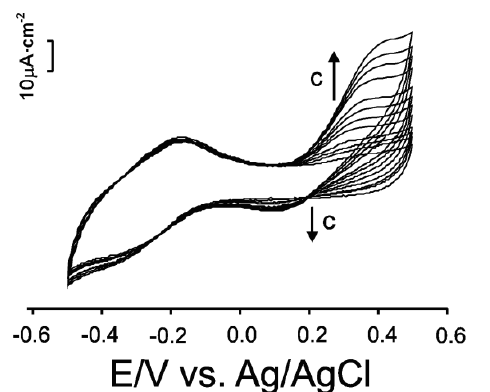
Figure 3. Cyclic voltammograms of a Ty/LuPc solutions (from 10 μ M to 40 mM). Scan rate 0.05 V × s − 1 .